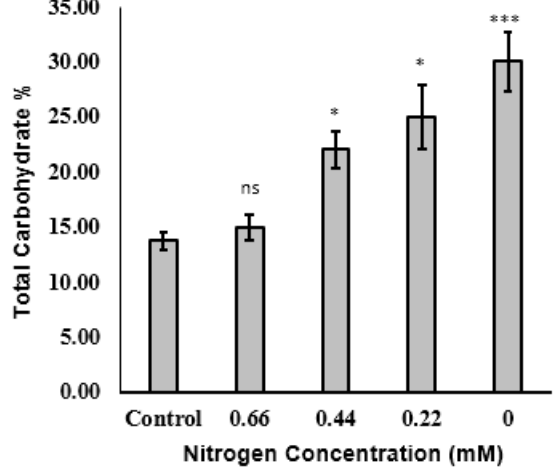
Figure 3. Total carbohydrate content (as % DW) of Tisochrysis lutea grown mixotrophically in different concentrations of NaNO 3. * p < 0.05, *** p < 0.001, ns: not significant with respect to the control (0.88 mM).